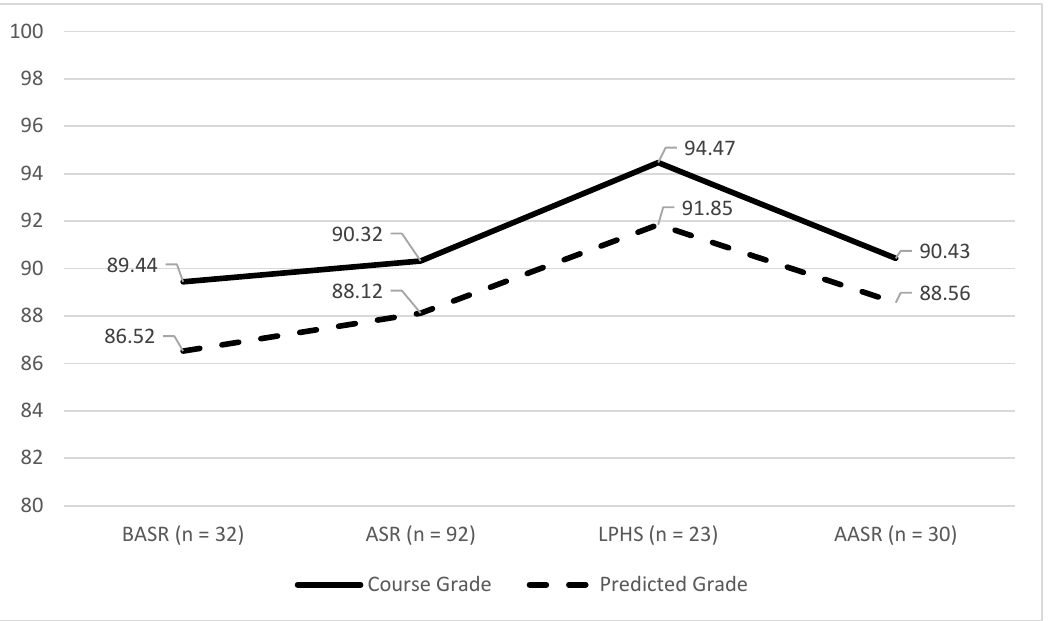
Average Course Grade and Predicted Grade by Latent